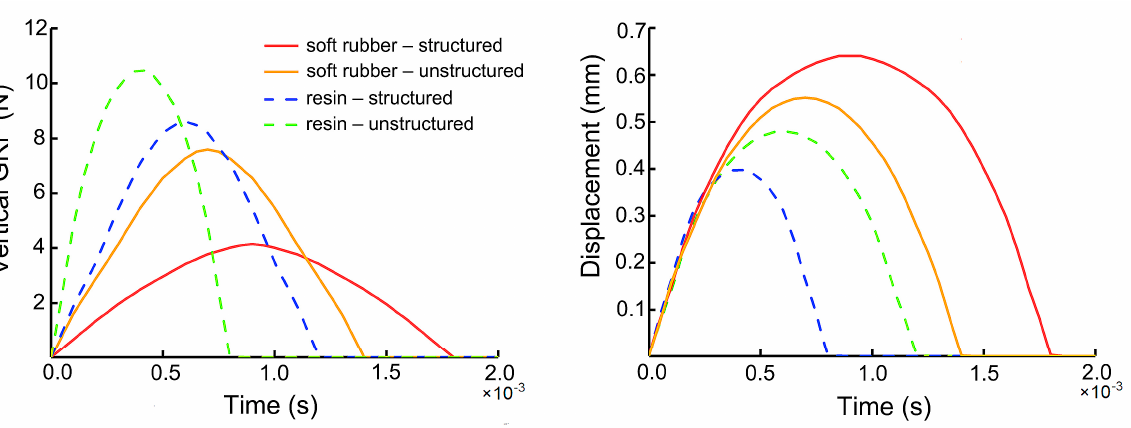
Figure 4. Vertical GRF and displacement (upper plate) of the four bionic heel pads under impact with an initial speed of 0.4 m/s in FE simulations.